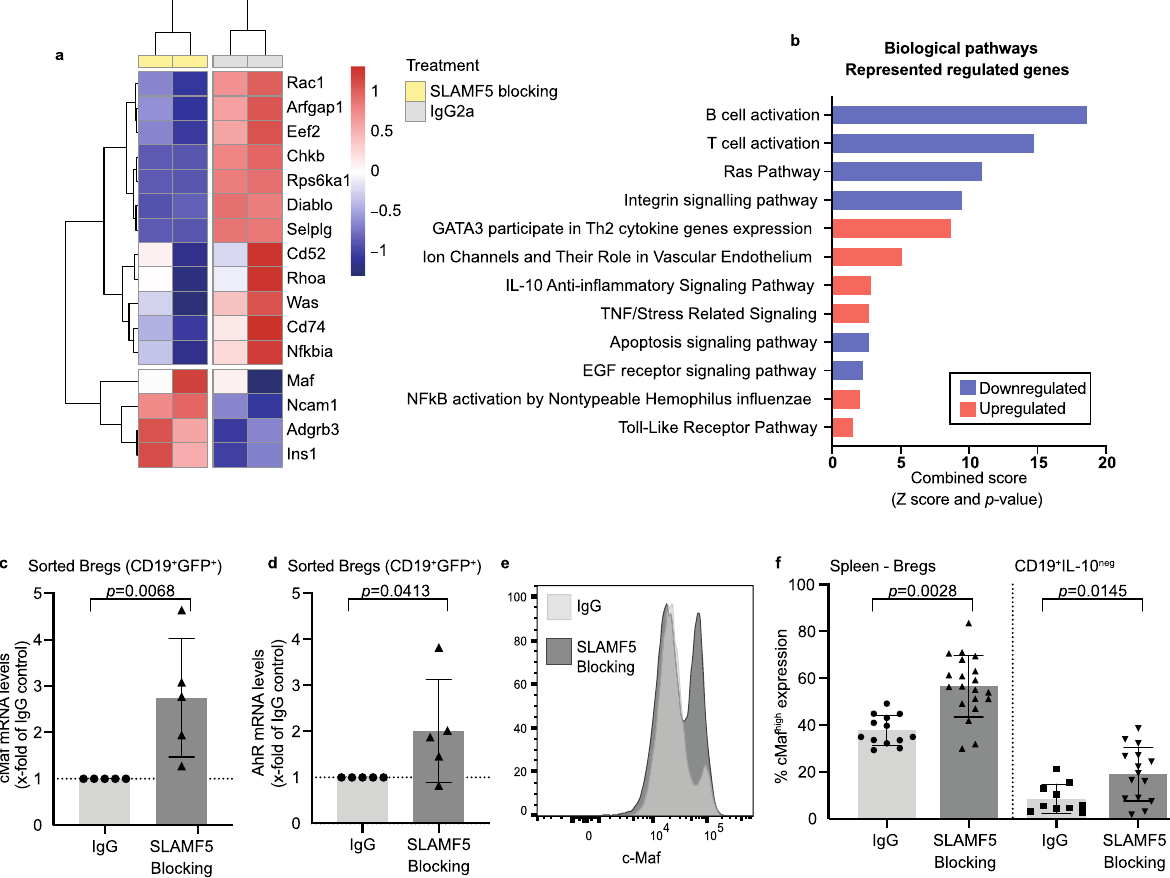
Fig. 5 SLAMF5 regulates the transcription factor c-Maf. B cells derived from EAE-induced Vert-x mice were sorted for Bregs (CD19 + GFP + ) and treated for 24 h with SLAMF5-blocking or IgG-control antibodies. RNA was then extracted from the cells and analyzed. a , b mRNA-seq analysis of differentially expressed genes in anti-SLAMF5 compared to IgG-treated cells performed in two independent replicates. a Heatmap showing differentially expressed genes, with the log2 normalized counts standardized for each gene to a mean of zero. The hierarchical clustering of the genes is shown. The expression pro fi le is accompanied by a colored bar indicating the standardized log2 normalized counts. Blue: downregulated; red: upregulated genes. b Pathway enrichment analysis of 277 genes that were found to be signi fi cantly changed (absolute change > 2; P value < 0.05) was done using the EnrichR platform; the graph shows upregulated (red) and downregulated (blue) pathways (IgG n = 2; SLAMF5-blocking n = 2, each sample is a pool of cells derived of three mice). c qPCR validation analysis of c-Maf mRNA in SLAMF5-blocked Vert-x sorted Bregs (CD19 + GFP + ) (IgG n = 5; SLAMF5-blocking n = 5. Each dot represents a pool of two to three mice, four independent experiments). d AhR mRNA levels in Vert-x sorted Bregs following SLAMF5-blocking. Data are shown as x -fold of the treatment group compared to IgG-control (IgG n = 5; SLAMF5-blocking n = 5. Each dot represents a pool of two to three mice, four independent experiments). e , f EAE was induced in WT mice. On days 7, 9, and 11, the mice were injected i.v. with 30 µ g SLAMF5-blocking Ab or IgG. On day 15, spleens were collected and analyzed for c-Maf expression by FACS. e Representative histogram showing c-Maf high expression of Bregs or non- Bregs. f Bar chart showing c-Maf levels in Bregs and non-Bregs. (non-Bregs: IgG n = 10; SLAMF5-blocking n = 15, Bregs: IgG n = 5; SLAMF5-blocking n = 10, two independent experiments). C-Maf expression was done under the Breg or non-Breg gate as shown in Supplementary Fig. 2c. Data expressed as mean ± s.d. ( c , d , f ). Ratio paired Student ’ s t test with 95% con fi dence levels two-tailed ( c , d ), unpaired Student ’ s t test with 95% con fi dence levels two- tailed ( f ). Pathway analysis was done using EnrichR and showing combined score (combined = ln( P value) x z-score. P value is derived from Fisher ’ s exact test, z-score is derived of a modi fi ed Fisher exact